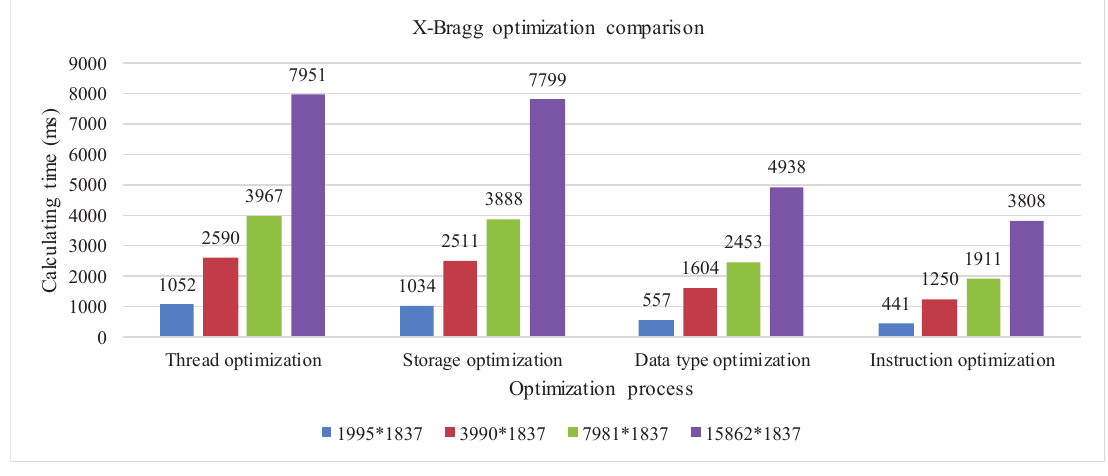
Figure 11. Results of using different optimization